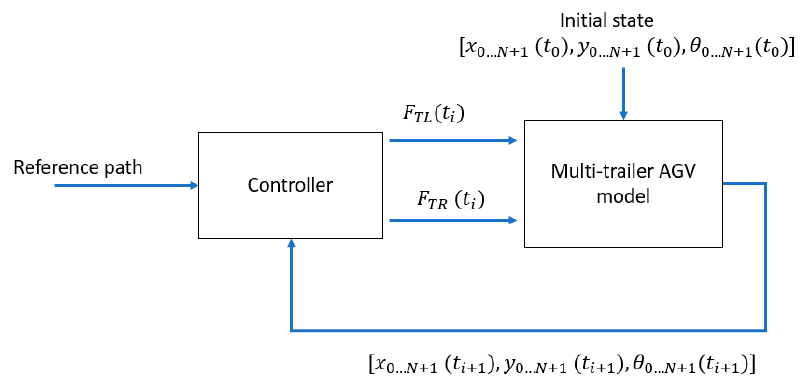
Figure 3. Multi-trailer AGV model and control interaction architecture.